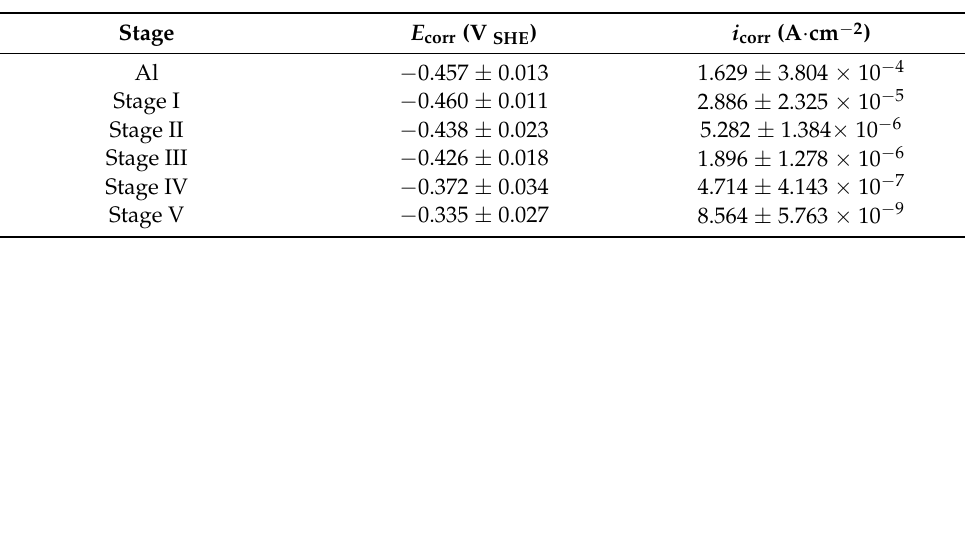
Figure 9. Potentiodynamic polarization curves for pure Al with and without PEO coating at different stages in 3.5 wt.% NaCl solution. Table 4. Electrochemical parameters of PEO coating on Al at different